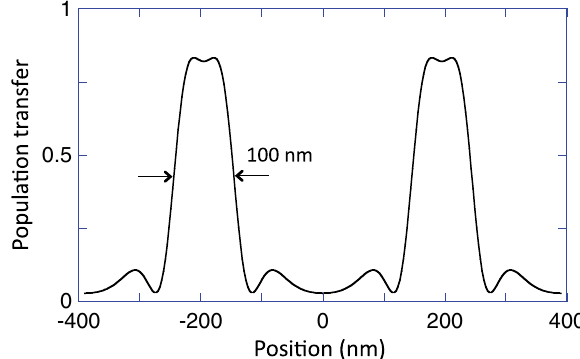
FIG. 7. The inferred population transfer from F ¼ 1 to F ¼ 2 along two cycles of the standing wave for the conditions of the experiment of Fig. 6(b). This transfer curve is the result of the same simulation that produces good agreement with the experi- mental data of Fig. 6(b). The inferred width of the transfer is 100 nm, which is a factor of 8 smaller than the wavelength of the EIT laser